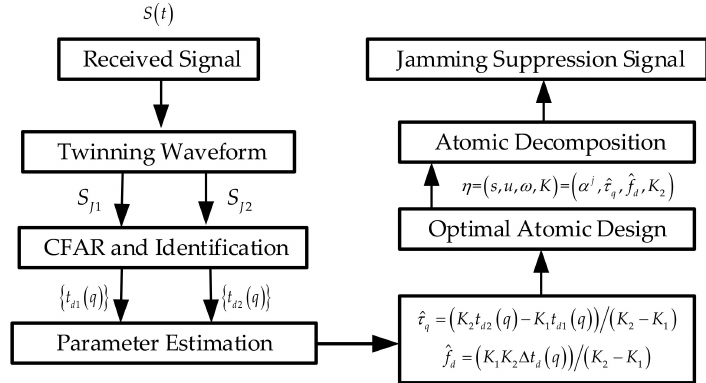
Figure 2. Jamming suppression